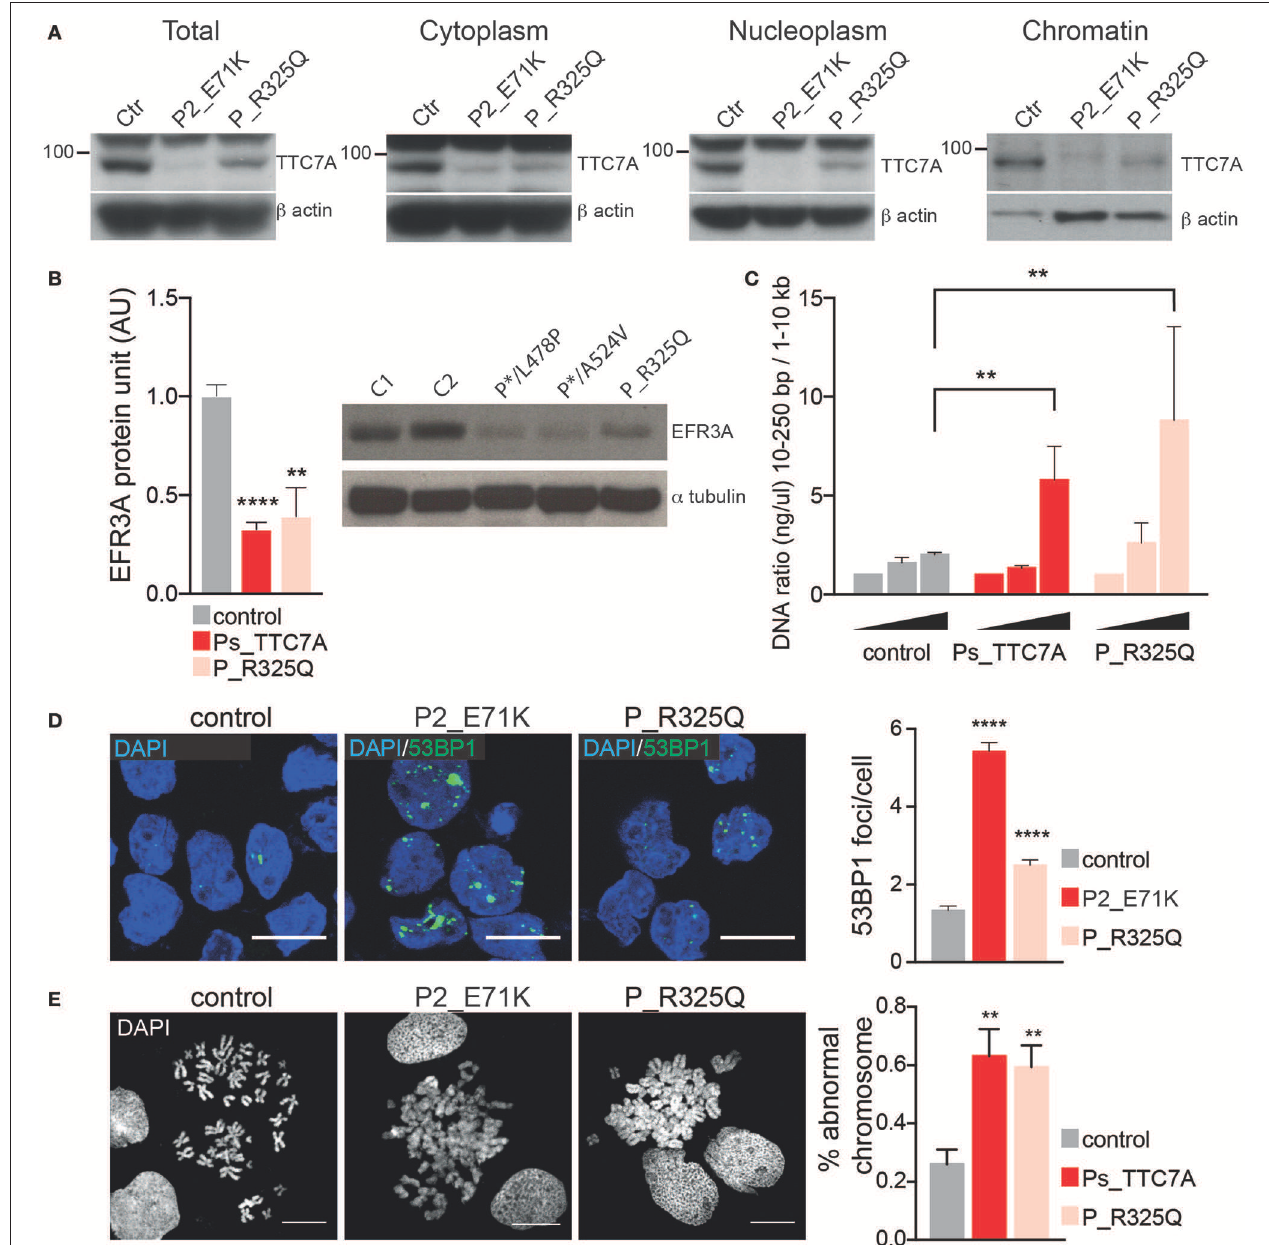
FIGURE 2 | Phenotypic consequences of R325Q mutation. (A) The expression level of TTC7A protein (96 kDa) is decreased in the different cellular compartments extracted from B lymphoblastoid cell lines (B-LCLs) from R325Q_TTC7A (P_R325Q) patient and from TTC7A-deficient patient (P2_E71K) as compared to healthy donors (Ctr). β actin was used as an internal loading control in the western blot. (B) The expression level of the protein EFR3 homolog A (EFR3A) is decreased in B-LCLs from R325Q_TTC7A patient and from TTC7A-deficient patients (P*/L478P and P*/A524V), as compared to control. The level of EFR3A protein was determined by western bot and the graph represents average level from three independent experiments, error bars indicate standard error of the mean ( ± SEM). Previously reported TTC7A patients are indicated as Ps_TTC7A when grouped. Unpaired t -test; ** p = 0.002, **** p < 0.0001. (C) DNA accessibility is increased in B-LCLs from P_R325Q and from Ps-deficient patients (P1_E71K, P2_E71K, P*/L478P) as compared to control. The concentration of digested DNA was measured at different time points and the ratio between small and large size DNA fragments are shown in the graph. The graph indicates the average of DNA ratio measured from four independent experiments ( ± SEM), Mann-Whitney test, ** p < 0.01. (D) DNA damage is increased in patients’ B-LCLs as compared to control, with an accumulation of 53BP1 foci. Left: immunostainings of 53BP1 imaged by confocal microscopy, Right: quantification of 53BP1 foci number. Graph represents the average count obtained from two independent experiments (Mean ± SEM). Total number of cells in control = 508; P2_E71K n = 315; P_R325Q n = 452; Sidak’s multiple comparisons test, **** p < 0.0001. (E) Impaired chromatin condensation of patients’ B-LCLs as compared to control. Left: chromosomes are stained with DAPI and imaged by confocal microscopy. Right: quantification of chromosomes with abnormal structure was performed on four independent experiments and the average count is shown in the graph ( ± SEM). Unpaired t -test, p = 0.0076 for Ps_TTC7A (P1_E71K, P2_E71K and P*/L478P) vs. control, and p = 0.006 for P_R325Q vs. control. Scale bar: 10